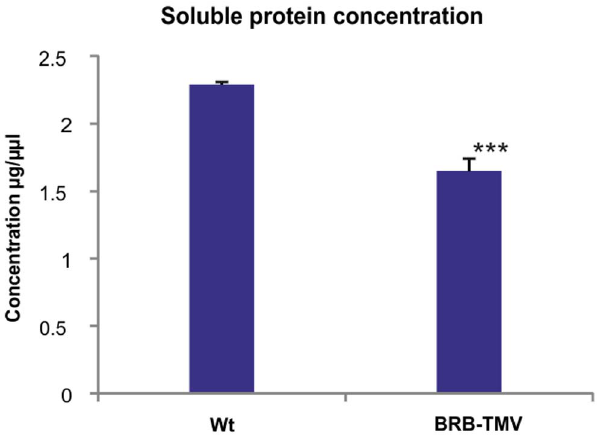
Figure 4. Lowry-quantitation of the soluble protein content of the BRB-TMV plants and of the corresponding wt control plants. Standard error of mean is presented as bars above the columns (consisting of three biological replicates). The confidence level determined by the Student’s T-test, with confidence level higher than 95% is indicated by *, higher than 99% indicated by **, and higher than 0,001 indicated by ***.